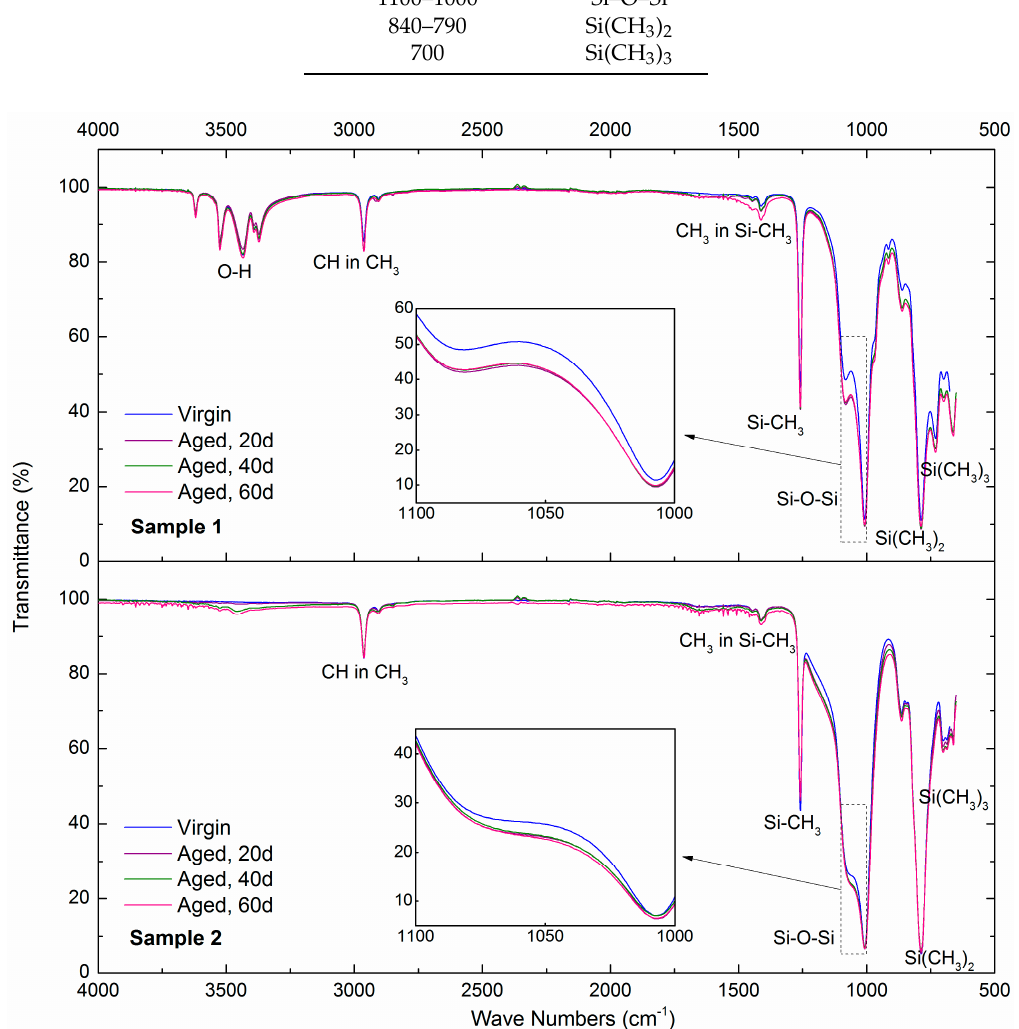
Figure 8. FTIR spectra of samples.